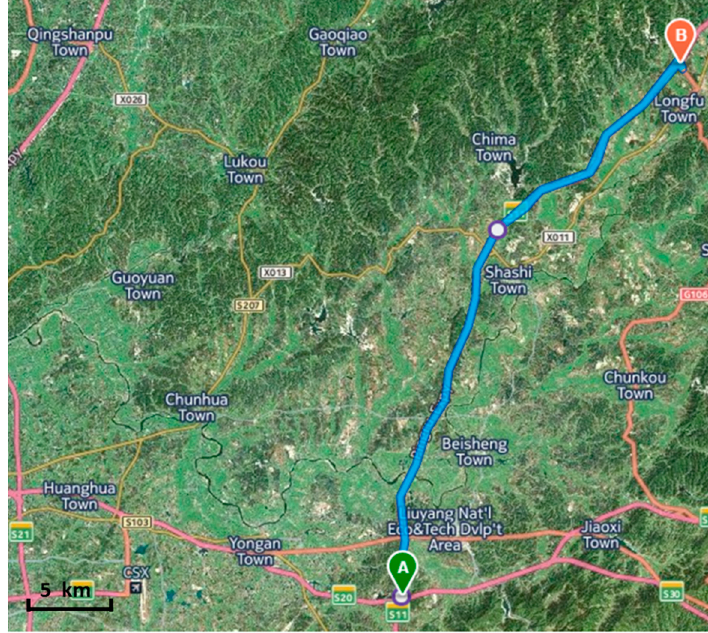
Figure 2. Survey map of the test in Eastern Changsha.